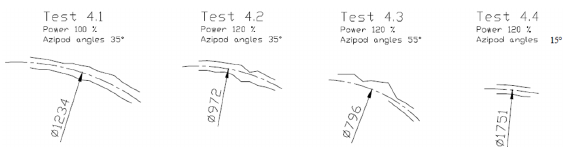
Figure 19: Simulated (left) and measured (right) veloc- ity time-series in 19 . 7 mm (0 . 5 m full-scale) level ice (power 120%, azimuth angle 55 ◦ ).